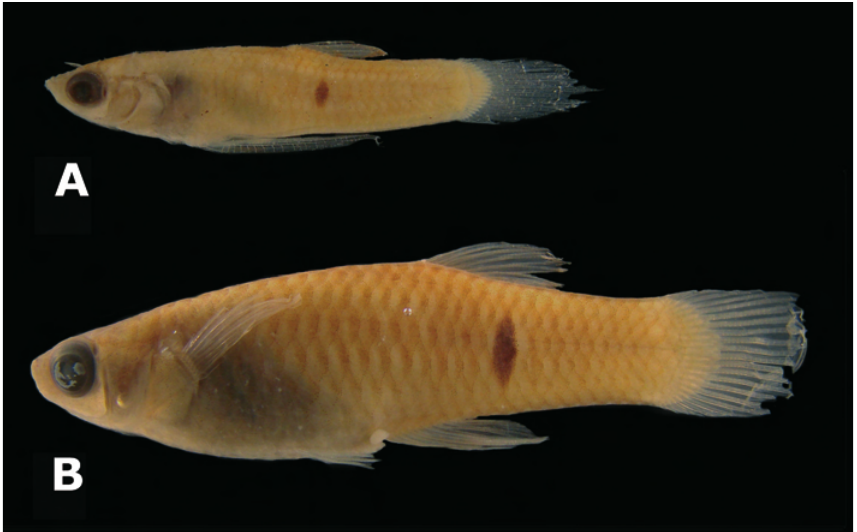
Fig. 34. Phalloceros malabarbai . (A) Holotype, male, 34.1 mm SL, MZUSP 79669, Itapoá, Santa Catarina, Brazil; (B) paratype, female, MZUSP 35422, 32.1 mm SL, collected with the holotype.